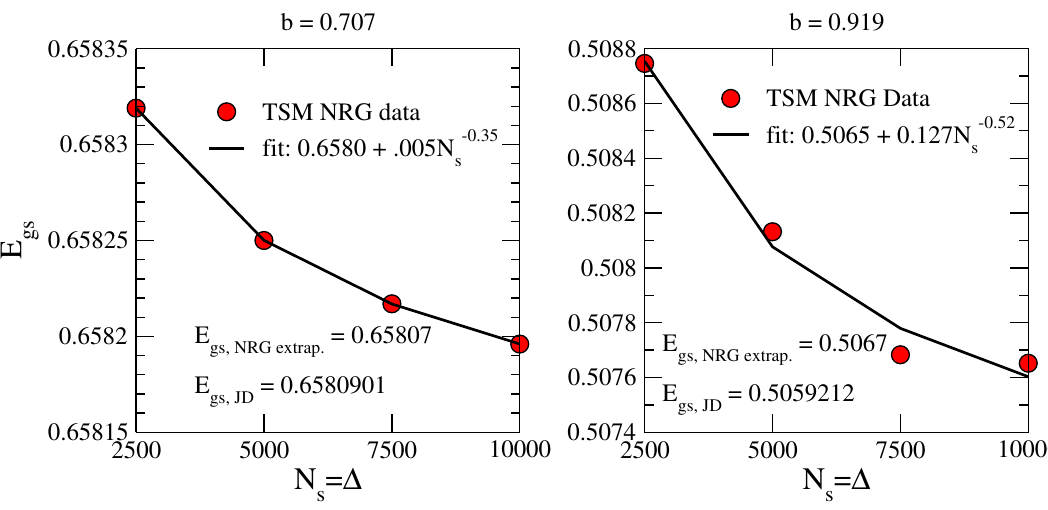
Figure 15. The ground state energy computed at N c = 14 and N ZM = 24 as a function of NRG block sizes N s = ∆ . Left panel: Computation at parameters b = 0 . 707 , R = 3 . 0 , µ ShG = 0 . 1 . Extrapolating the NRG data to where it would correspond to a JD computation we obtain E gs , NRG extrap . = 0 . 65807 in comparison to the exact JD value, E gs , JD = 0 . 6580901 . Right: Computation at b = 0 . 919 , R = 3 . 0 , µ ShG = 0 . 1 . Here we find E gs , NRG extrap . = 0 . 5067 and E gs , JD = 0 . 5059212